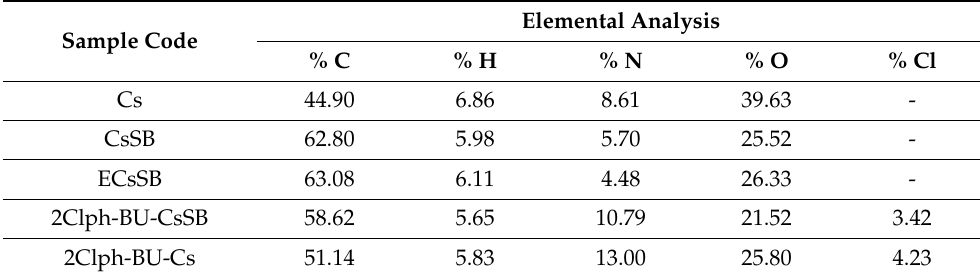
Table 1. Elemental analysis of the modified Cs